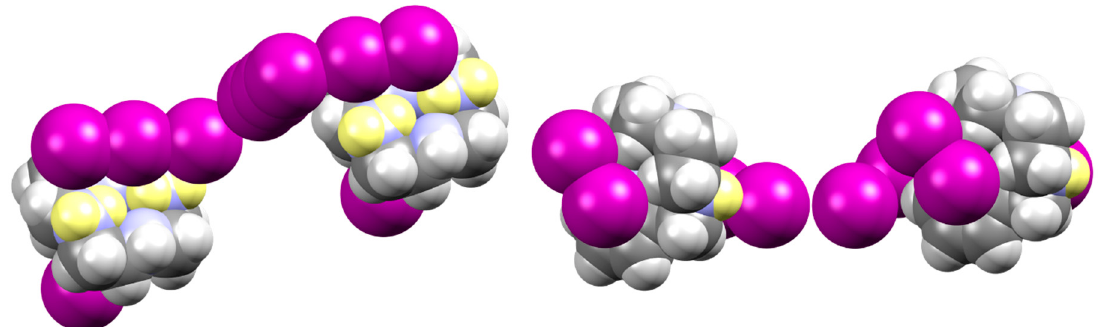
Figure 11. View of both sides of the azacyclophanes and of their interactions with iodine-based species as found in the [(H 2 L1) 2 I 2 (I 5 )(I 3 ) 3 ] crystal structure. Color code: white, H; grey, C; cyan, N; violet I; H belonging to ammonium groups are highlighted in yellow.